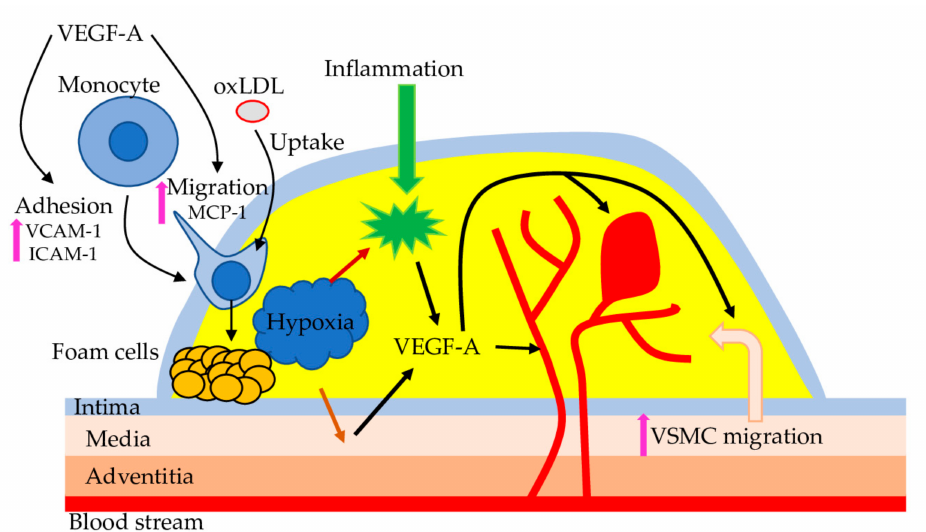
Figure 3. VEGF-A and atherosclerosis. Hypoxia and inflammation in the atherosclerotic plaque trigger VEGF-A expression in VSMC and macrophages. VEGF-A promotes endothelial expression of adhesion molecules and secretion of chemotactic substances to stimulate monocytes’ recruitment, adhesion, and transmigration into the blood vessel wall. Further, monocytes differentiate into macrophages and accumulate oxidized LDL (oxLDL), leading to foam cell formation. In addition, VEGF-A promotes migration of VSMC from the tunica media of the blood vessel wall into the plaque, which could initiate platelet activation and aggregation, resulting in thrombus formation. Also, VEGF-A acts on the blood vessel to promote angiogenesis, associated with